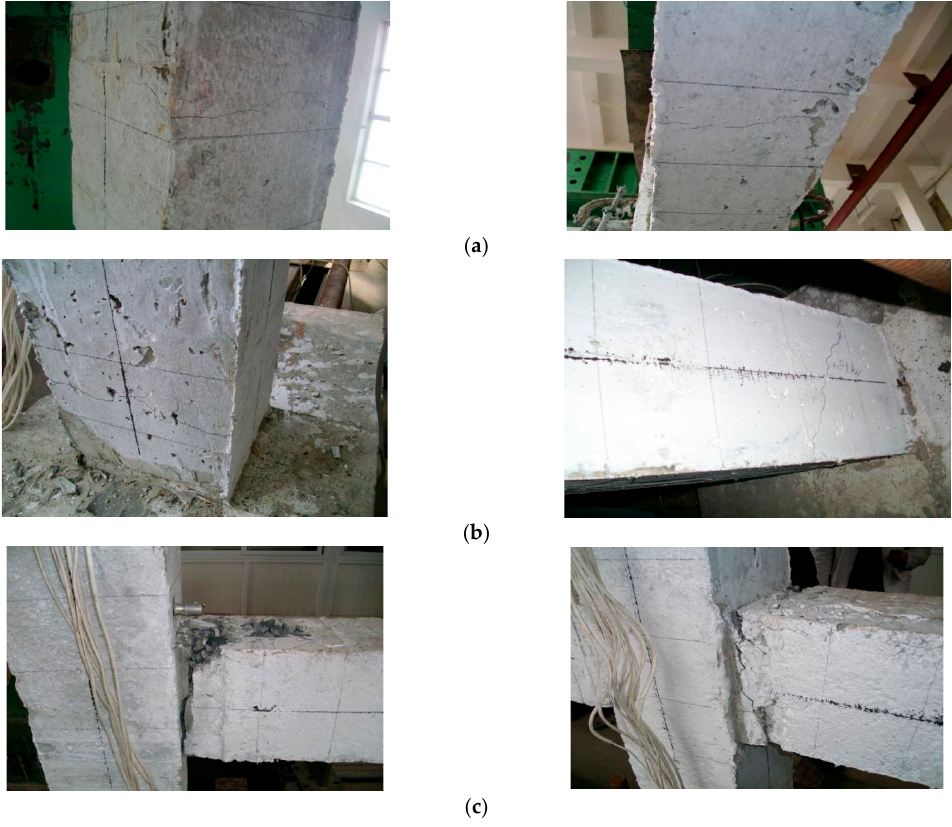
Figure 11. Experimental phenomenon diagram of KJ-1. ( a ) Cracks in the beams of KJ-3. ( b ) Cracks in the bottom of columns of KJ-3. ( c ) Failure modes of KJ-3.